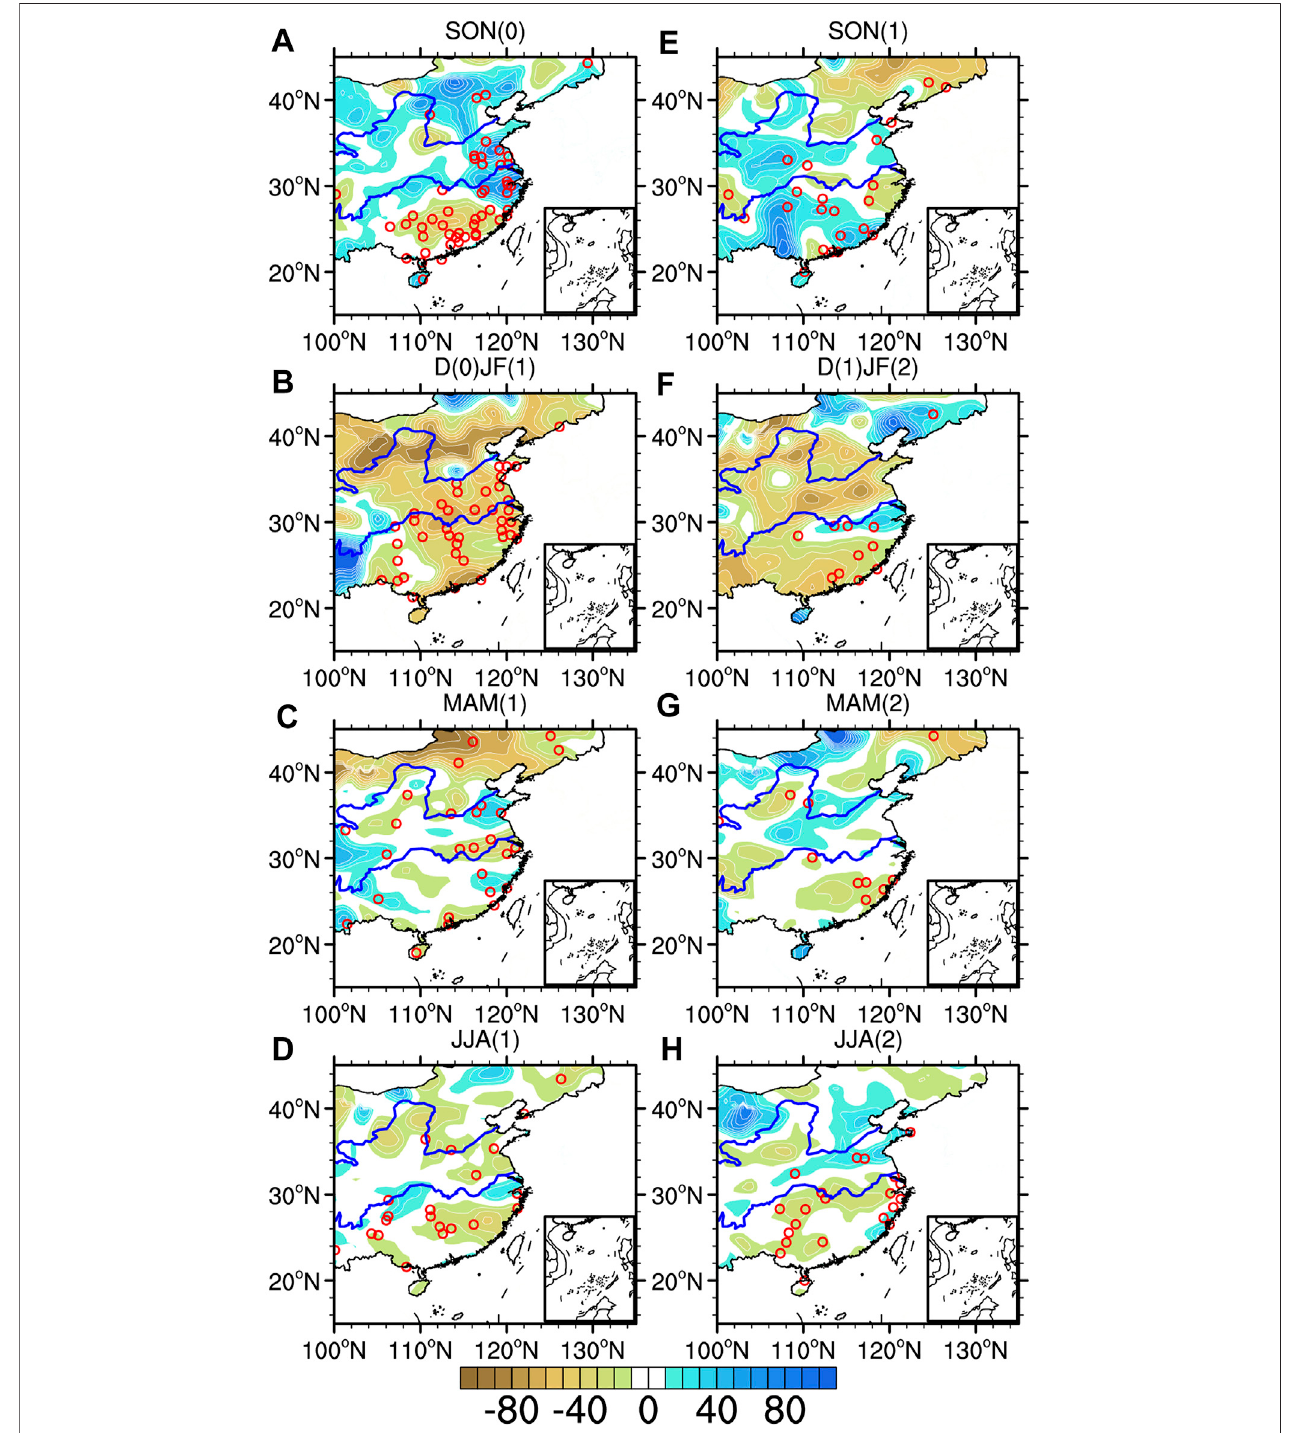
FIGURE4| Compositesofprobabilitychanges(units:%)insouthernChinaduring (A) SON(0), (B) D(0)JF(1), (C) MAM(1), (D) JJA(1), (E) SON(1), (F) D(1)JF(2), (G) MAM (2), and (H) JJA (2). Red circles indicate values at 699 meteorological stations exceeding the 90% con fi dence level determined using a two-tailed Student ’ s t test.